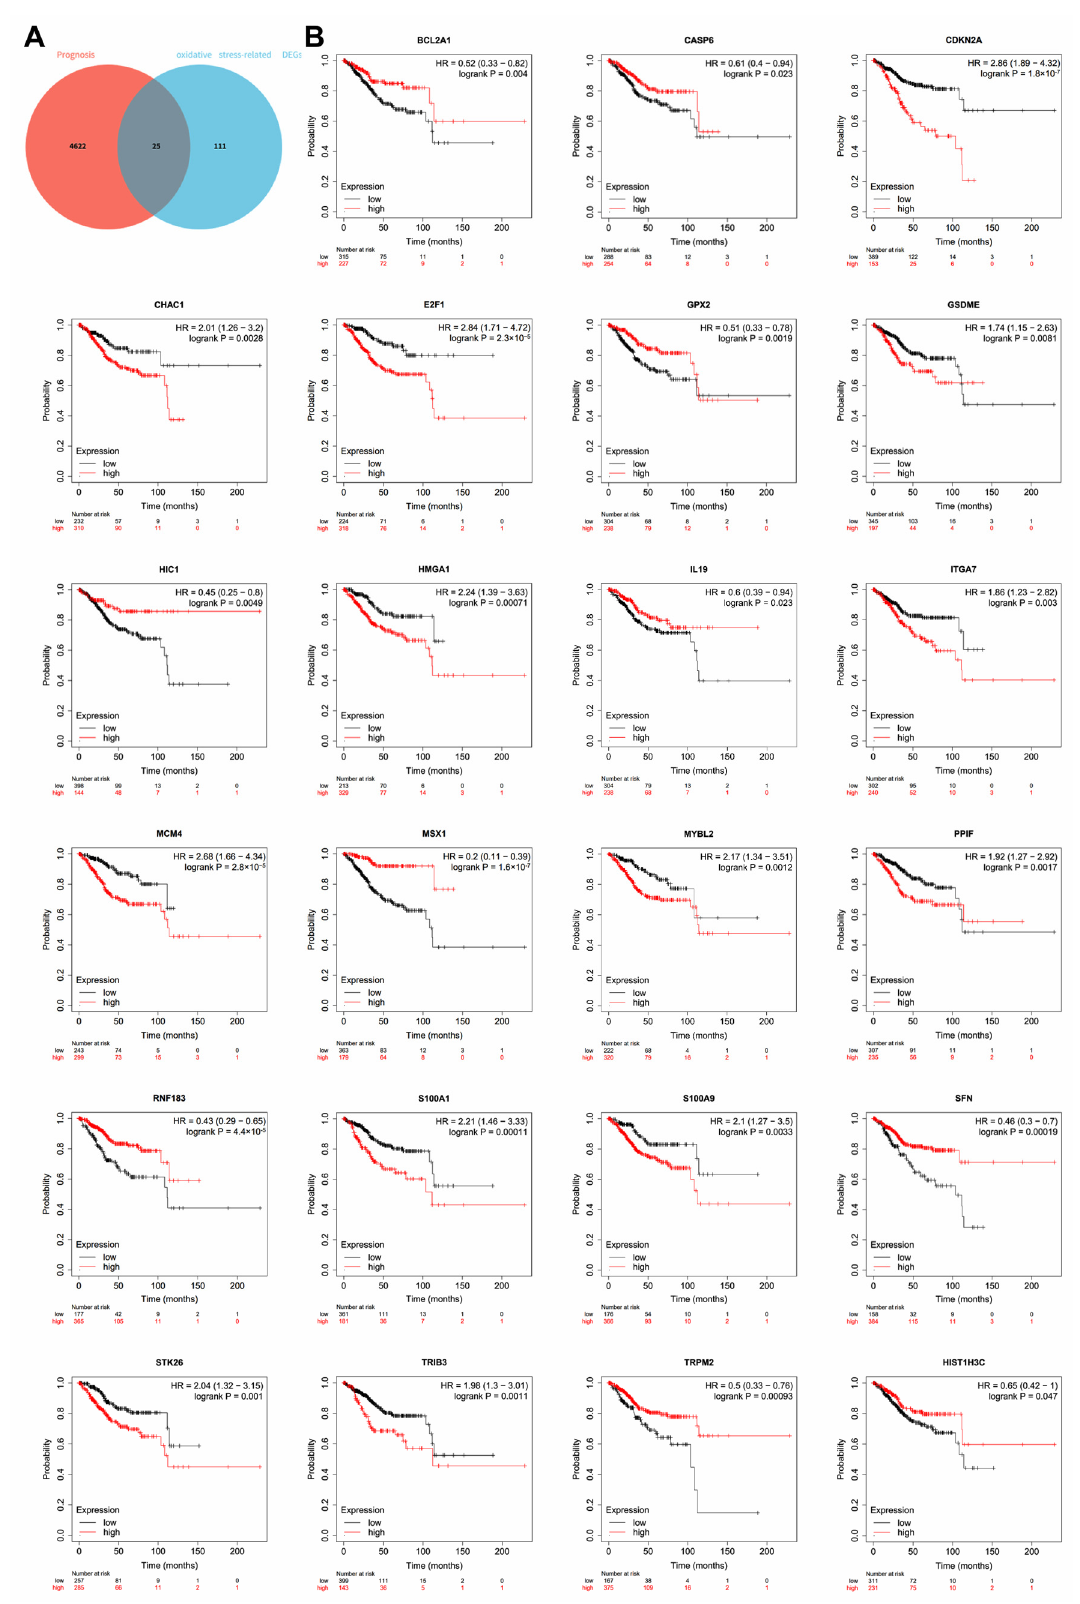
Figure 3. ( A ) Venn diagram of the intersection of prognostic genes in UCEC and differentially expressed OSRGs; ( B ) 23 oxidative stress-related DEGs assess the overall survival of UCEC. Note: UCEC: uterine corpus endometrial carcinoma; OSRGs: oxidative stress-related genes.